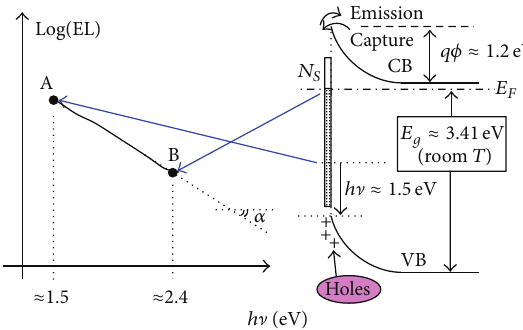
Figure 4: Semilog plot of the surface luminescence spectrum that must appear in n-GaN devices when holes are injected near their surface. Electrons in surface states (SE) using virtual states to accomplish radiative transitions to the valence band (see text) would reflect the exponential distribution with the energy of the